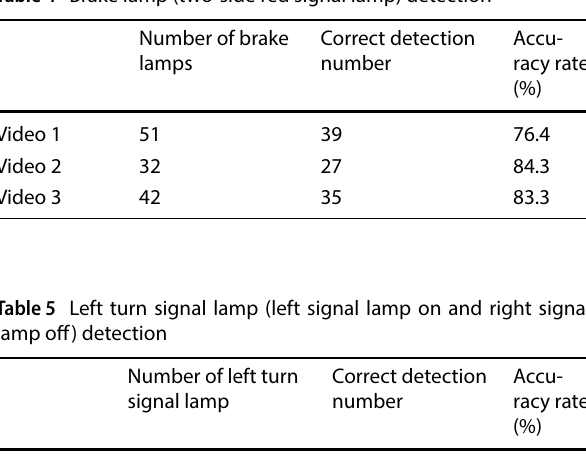
Table 4 Brake lamp (two-side red signal lamp) detection